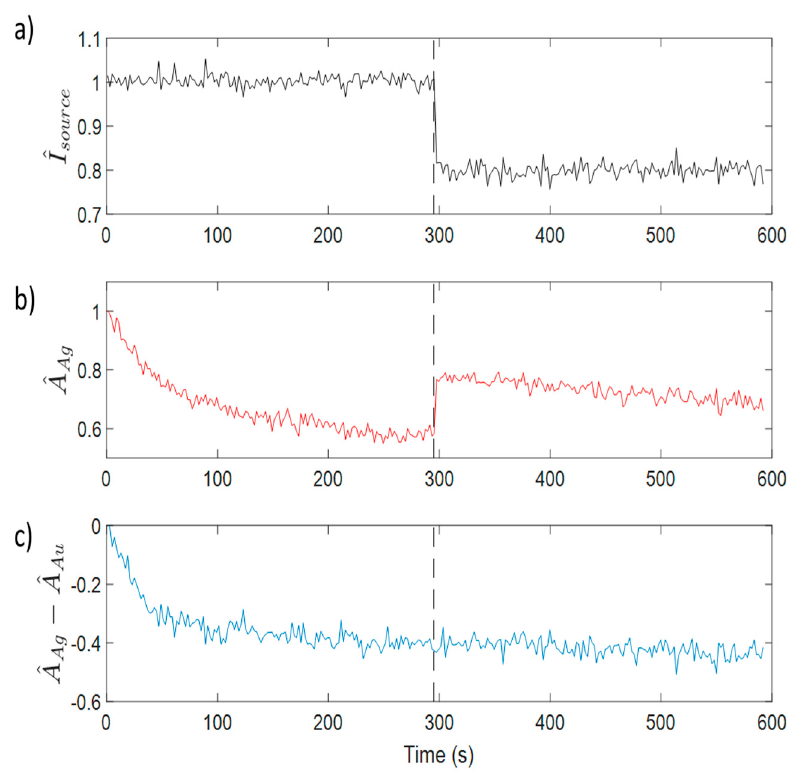
Figure 13. ( a ). Light intensity injected by the light source in the sensors. At 297 s into the experiment (dotted vertical line), an optical connector was loosened on purpose in order to decrease the light coming from the source by 30%. ( b ) Response of an AgLbL sensor. It is clearly shown how the source variation affects the signal, leading to a wrong peroxide reading. ( c ) Evolution of the differential indicator of a AgLbL + AuLbL sensitive coating. The signal remains almost intact in the case of the self-referenced sensor, even with such source variations.